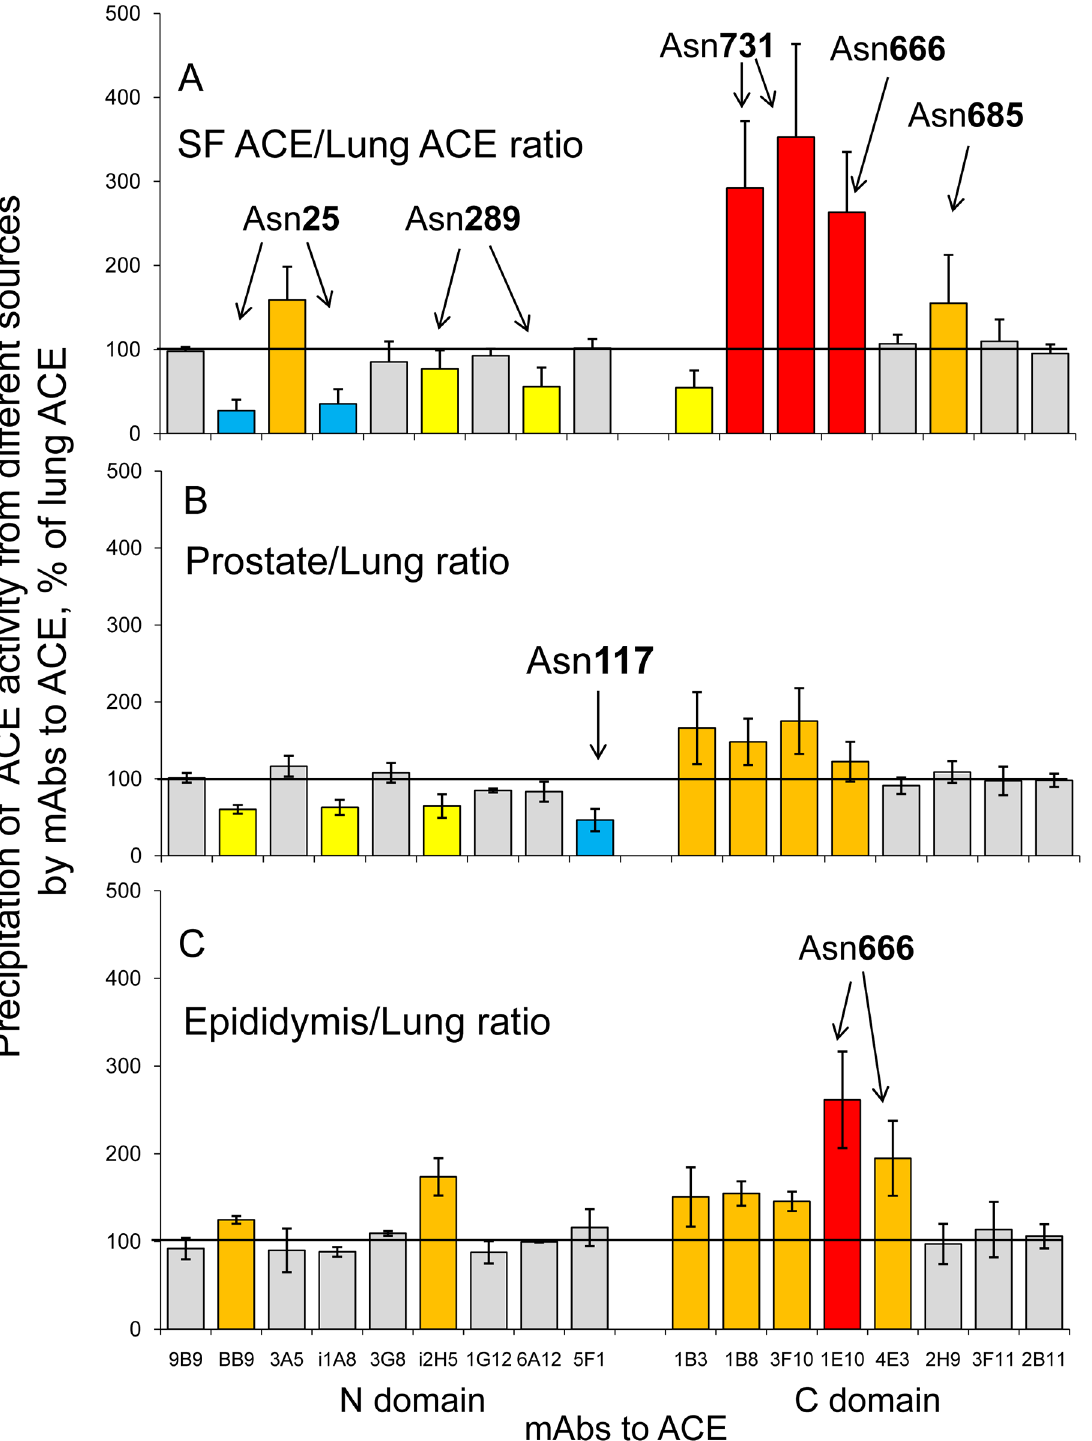
Fig 1. Immunological characterization of different ACEs. Conformational fingerprinting of different ACEs with a set of mAbs to ACE. Seventeen monoclonal antibodies (mAbs) were used to precipitate ACE from different sources. Immunoprecipitated ACE activity is presented as a normalized value ( “ binding ratio ” expressed as a percentage of the activity of ACE from one source to that from another source) to highlight differences in immunoprecipitation pattern ( “ conformational fingerprint ” ) among different ACE variants. (A) . The ratio of precipitated activity of pure seminal fluid ACE to that of pure lung ACE. B-C . The ratio of precipitated activity of ACE from prostate homogenate ( B ) or epididymis homogenate ( C ) to that of lung homogenate. Data are presented as